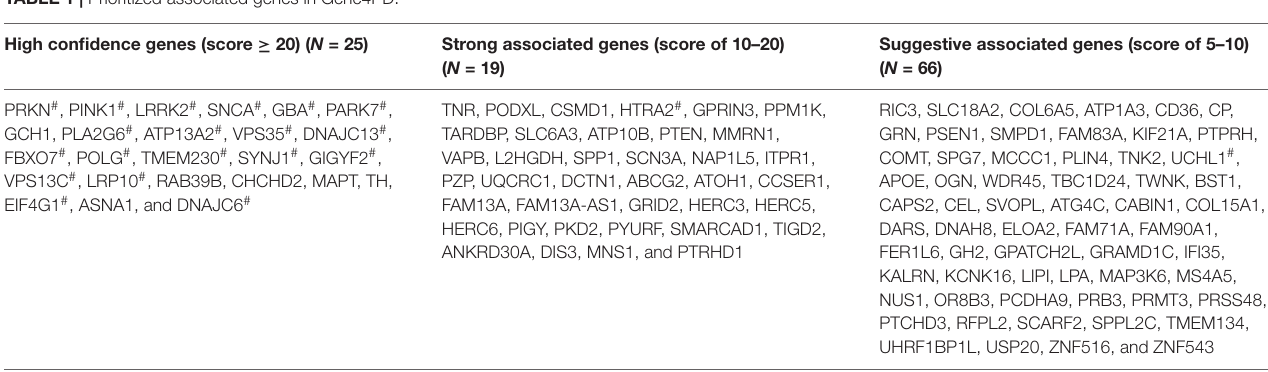
FIGURE 1 | The overall roadmap of this study. The above green dashed box is the process of data collection and analysis, and the below purple dashed box is the overall framework of Gene4PD. Gene4PD supports a “Quick search,” “Advanced search,” “Browse,” and “Analysis” service, as shown in the blue section. The annotation information at the variant level and gene level is shown in the lilac section. TABLE 1 | Prioritized associated genes in